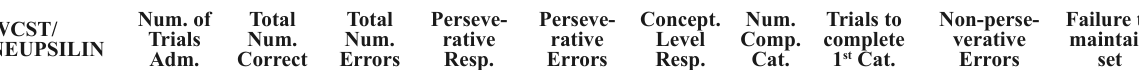
Perseve- Total Total Num. of rative Num. Num. Trials Resp. Errors Correct Adm.